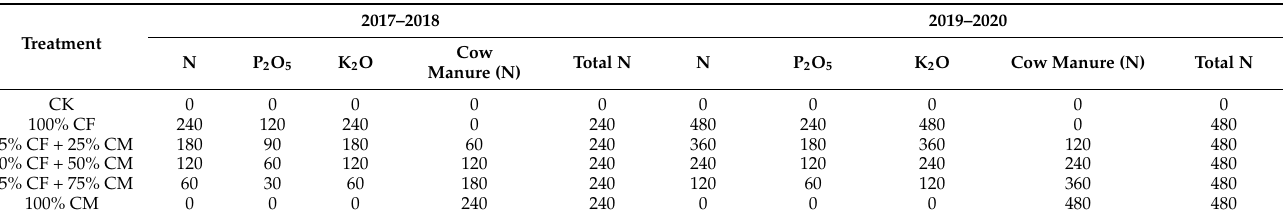
Table 1. Nitrogen, phosphorus, potassium and organic fertilizer inputs for different treatments (kg/hm 2